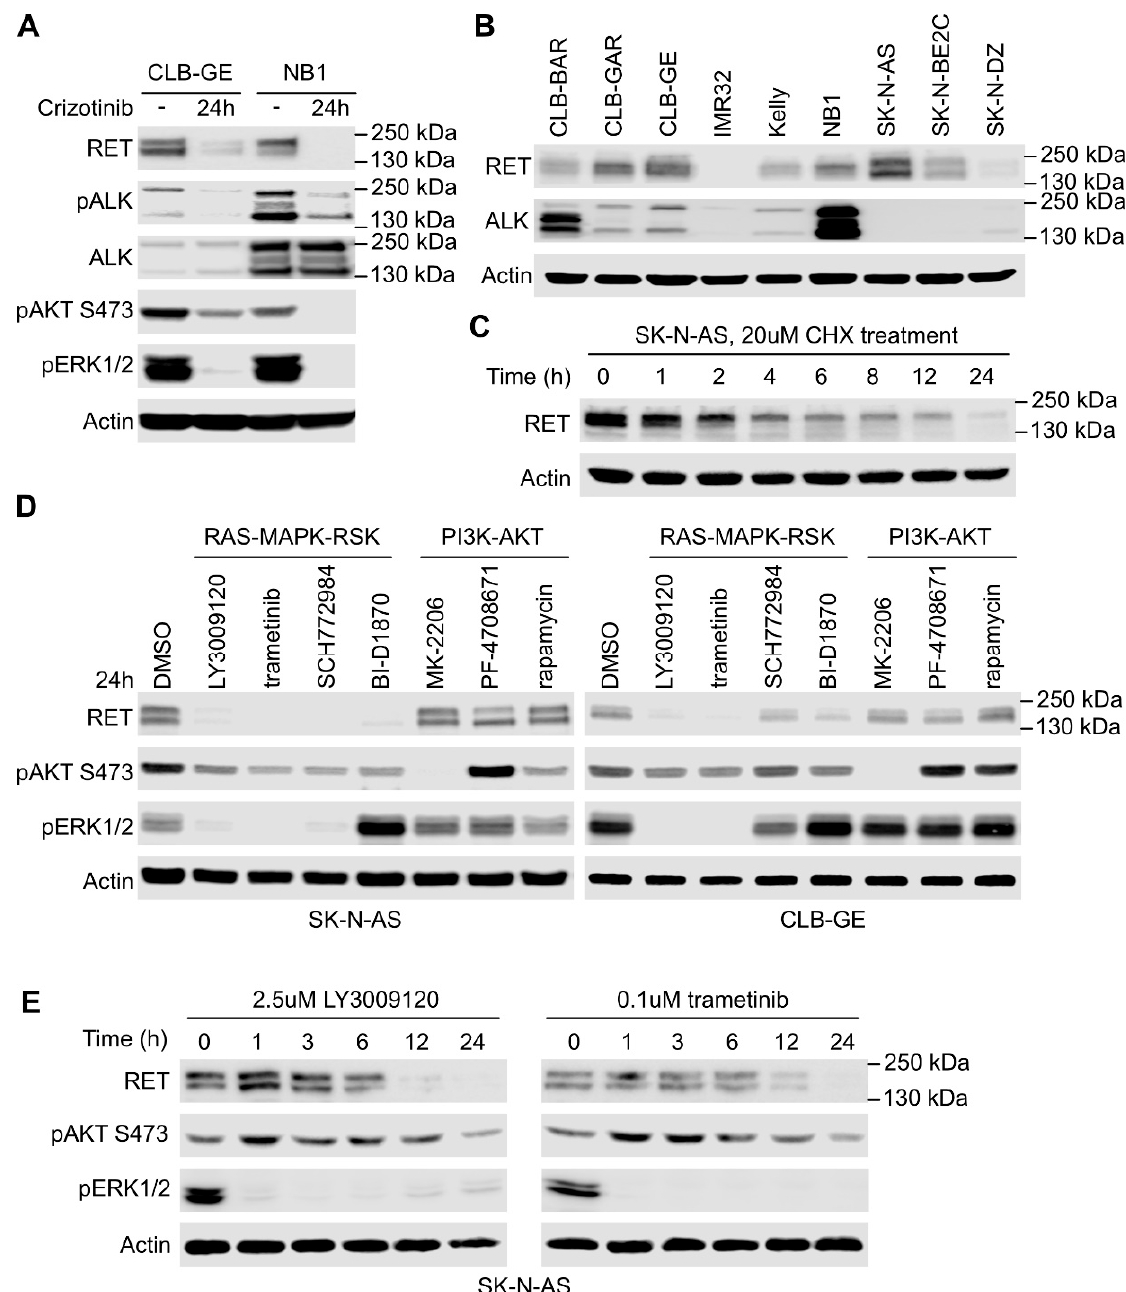
Figure 3. RAS/MAPK but not PI3K/AKT signaling pathway regulates RET expression. ( A ) Western blot analysis of the effect of ALK inhibition on RET expression. Two ALK-driven neuroblastoma (NB) cell lines, CLB-GE (ALK-F1174V) and NB1 (ALK-amplified), were treated with crizotinib for 24 h and total lysate was analyzed for proteins as indicated; actin was used as loading control. ( B ) RET and ALK protein expression profile in a panel of NB cell lines. ( C ) Western blot analysis of RET protein levels in response to cycloheximide (CHX) treatment in SK-N-AS cells. ( D ) RET protein levels in SK-N-AS and CLB-GE NB cells in response to inhibition of RAS/MAPK/RSK and PI3K/AKT/mTOR signaling pathways. Cells treated with solvent dimethyl sulfoxide (DMSO) were used as control. ( E ) Western blot analysis of RET protein levels over time in response to LY3009120 and trametinib treatment in SK-N-AS cells.